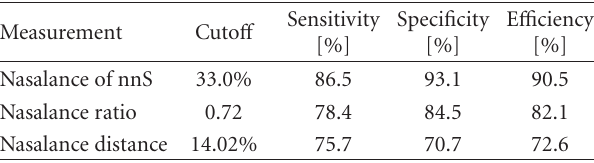
Table 6: Validation data for di ff erentiation between patients with no and borderline rhinophonia and patients with marked and severe